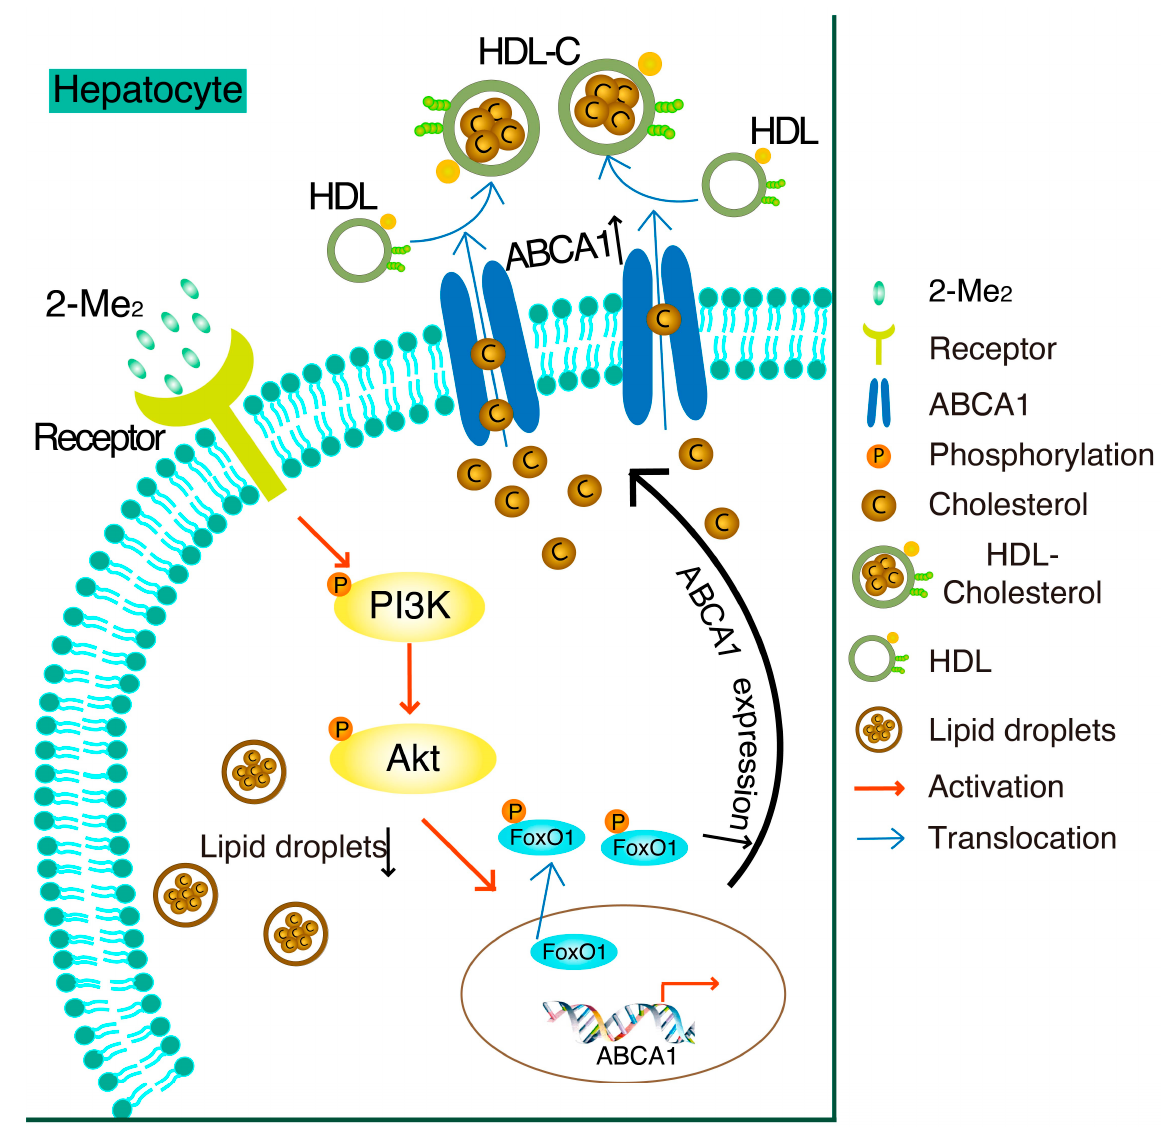
Figure 6. Schematic diagram of the mechanisms in 2-ME 2 -suppressed cholesterol accumulation by the upregulation of ABCA1 in HepG2 cells.